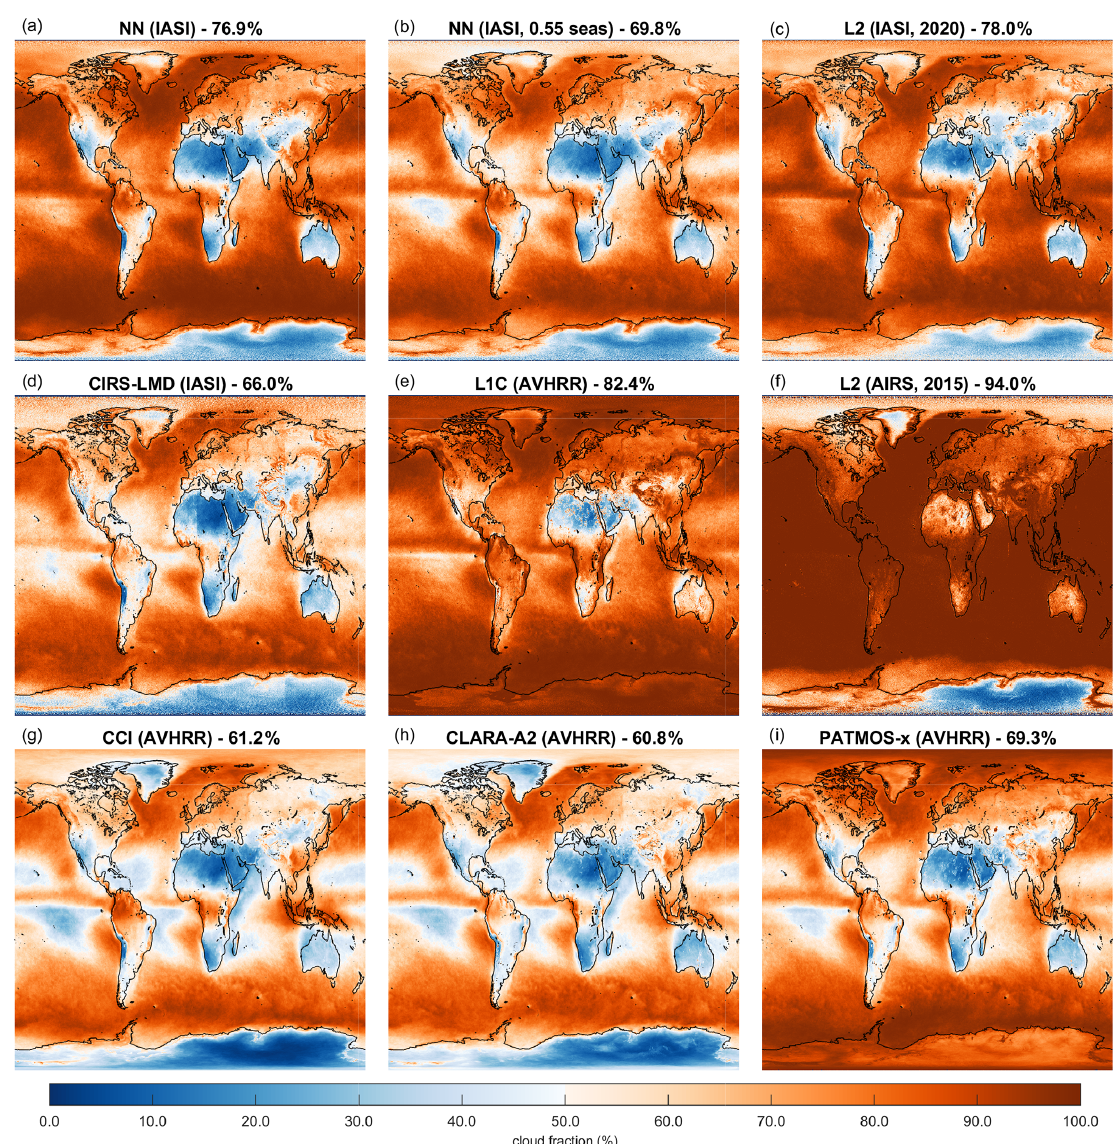
Figure 5. One-year-average cloud cover (%) from IASI-, AIRS- and AVHRR-derived cloud products (daytime observations). The year considered for the averaging is 2016, except for the EUMETSAT IASI-L2 product (2020) and the AIRS-L2 product (2015). The global mean cloud cover is provided on top of each